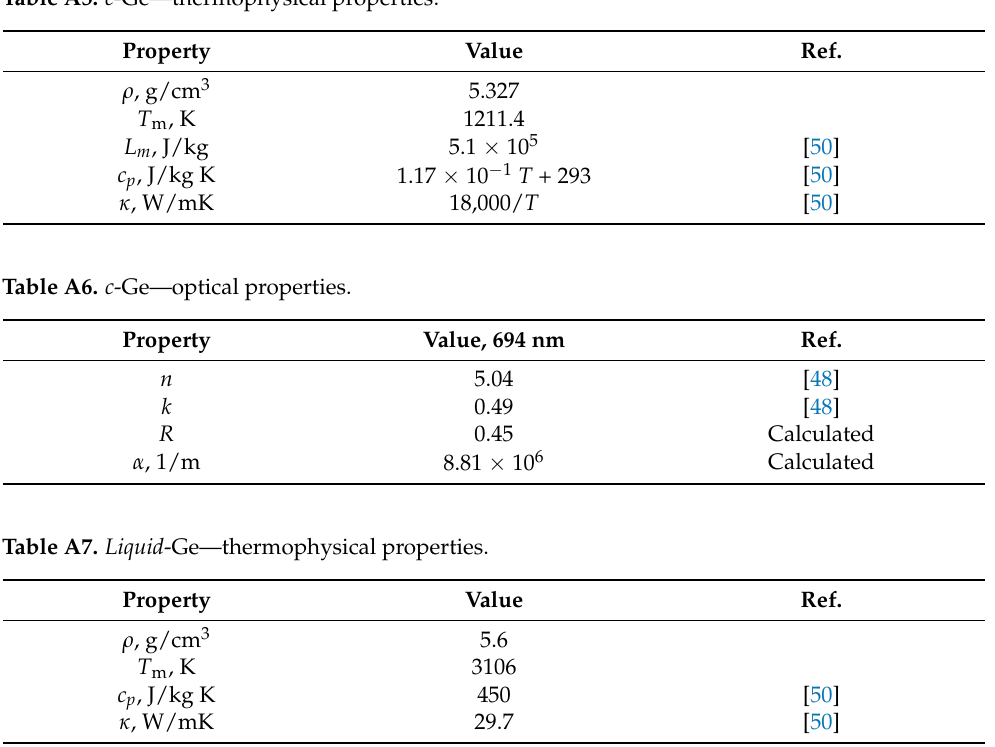
Table A5. c -Ge—thermophysical properties.